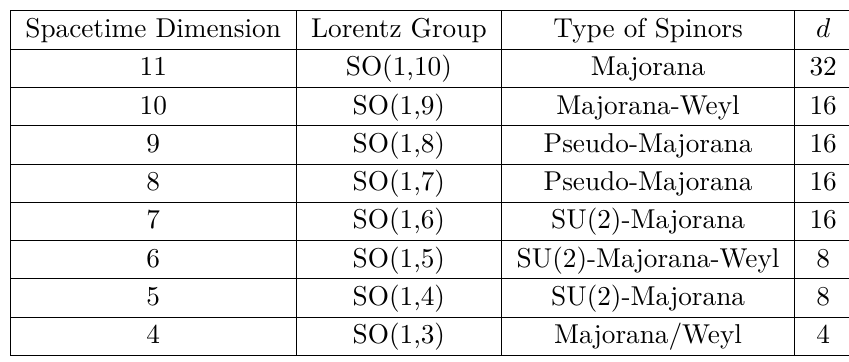
Table 1 . Summary of types of spinors in various dimensions